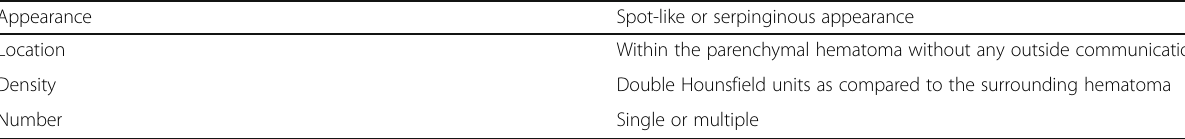
Table 3 Importance and interpretation of the CTA spot sign Appearance Location